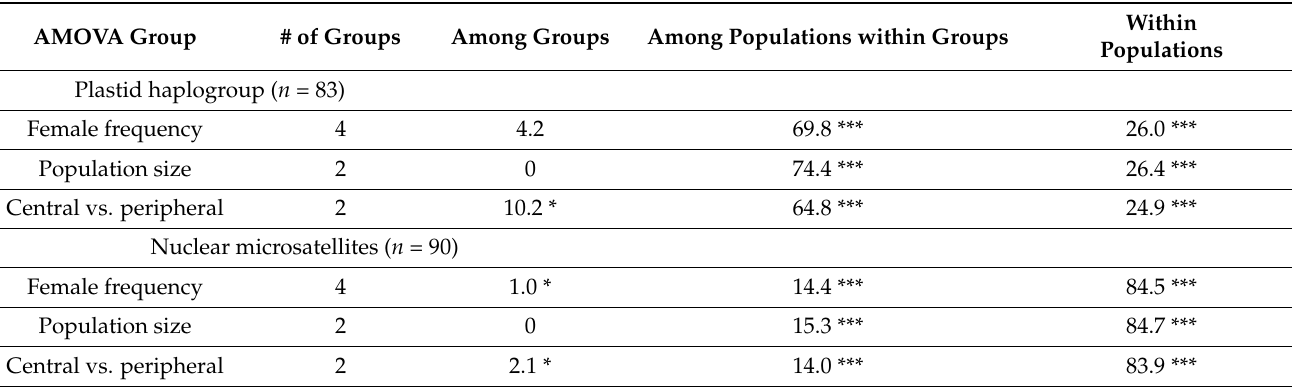
Table 1. Analyses of molecular variance based on Lobelia siphilitica plastid sequence data and three nuclear microsatellites. Population differentiation was approximated by pairwise differences for 83 populations and by the R ST -like sum of squared differences for 90 populations for plastid and nuclear data, respectively. Values represent the percent of variation explained by each